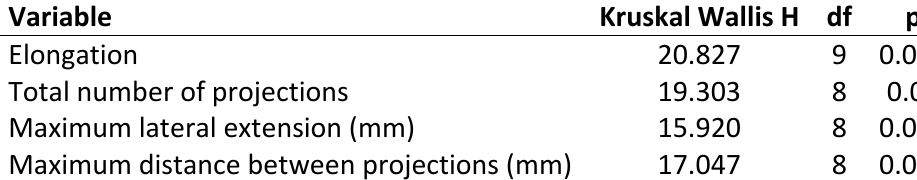
Table 8. Kruskal Wallis tests of raw material groups against biface variables.